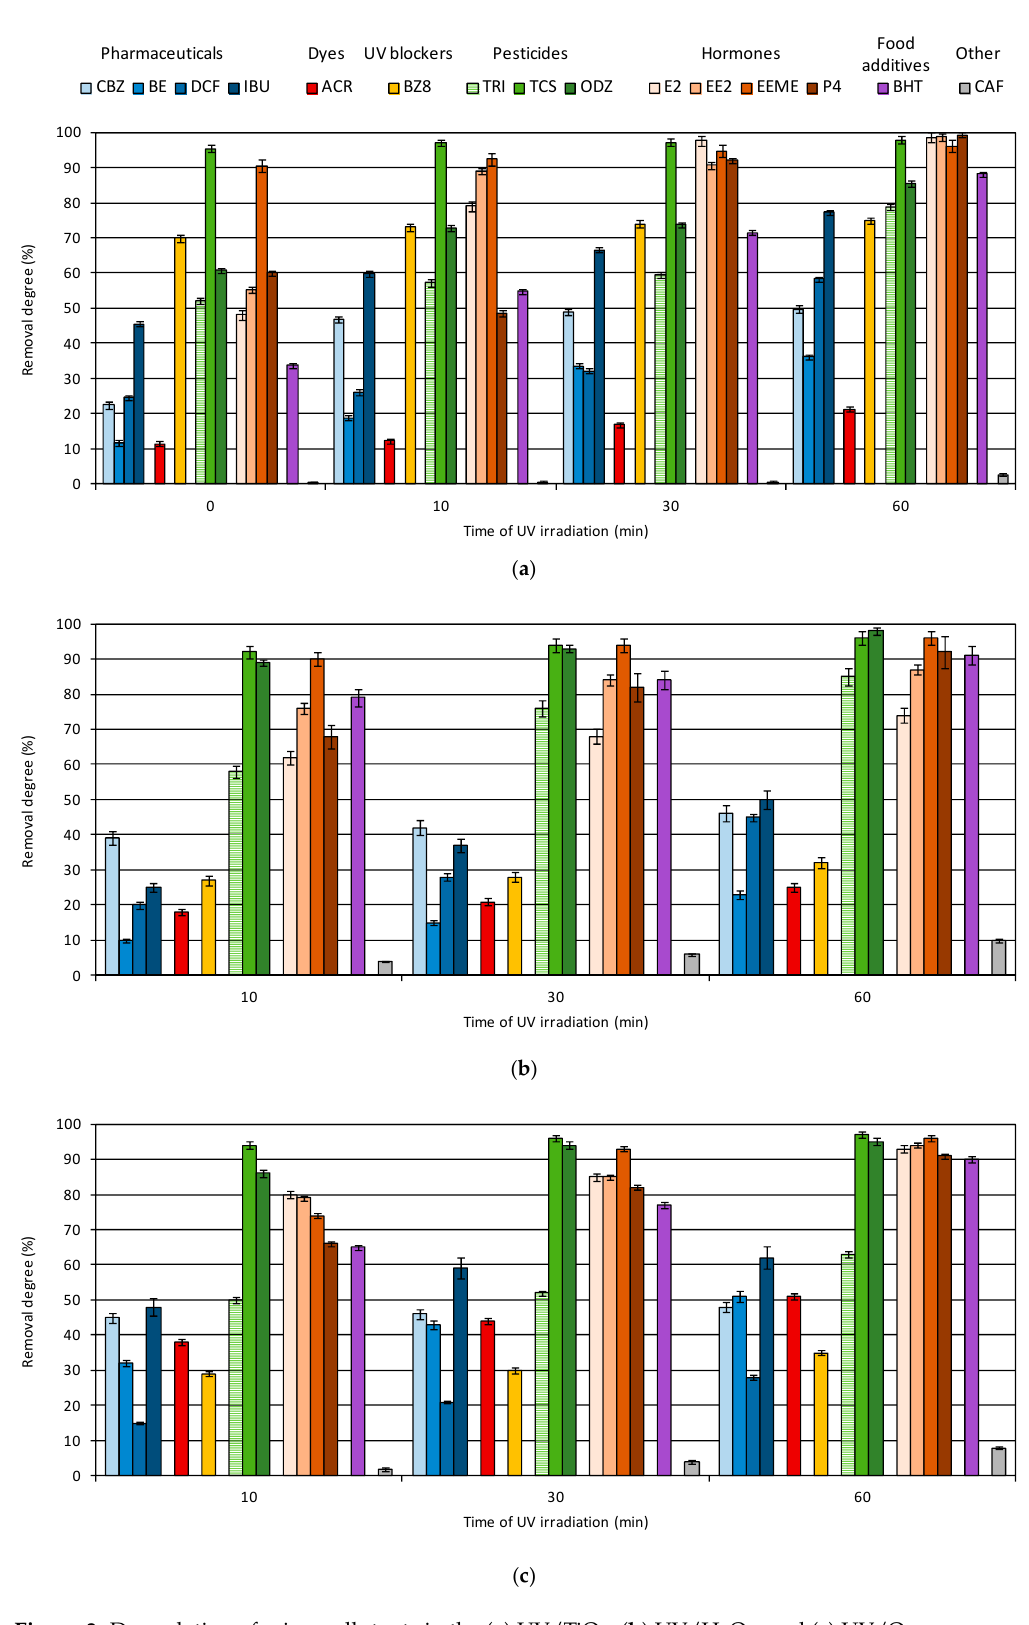
Figure 3. Degradation of micropollutants in the ( a ) UV/TiO 2 , ( b ) UV/H 2 O 2 , and ( c ) UV/O 3 processes (the doses of TiO 2 , H 2 O 2 and O 3 were equal to 50, 12 and 10 mg L − 1 respectively).